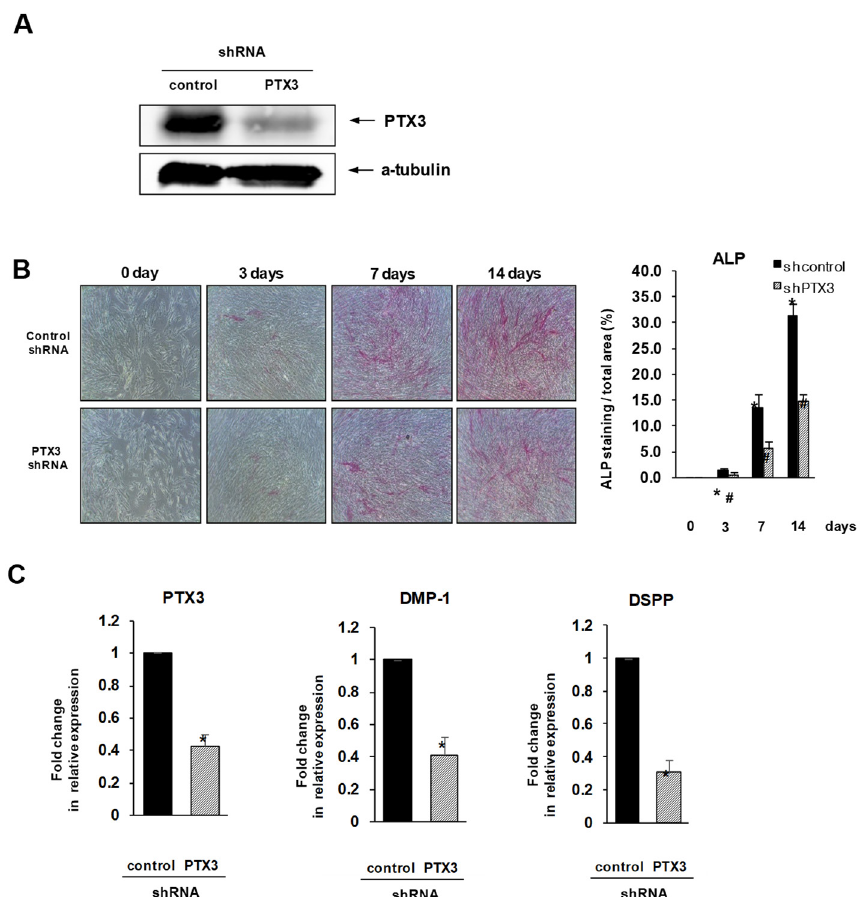
Figure 2. E ff ect of PTX3 knockdown on the expression of osteo / odontogenic di ff erentiation markers in human dental pulp stem cells. ( A ) HDPSCs were stably transduced with lentiviruses encoding PTX3 shRNA or control shRNA. PTX3 expression was analyzed using Western blot analysis. ( B ) HDPSCs transduced with PTX3 shRNA or the negative control shRNA were seeded in osteogenic media for the indicated number of days. ALP staining was conducted at days 3, 7, and 14. Stained cells were observed by a phase contrast microscope at 100 × magnification. ALP-positive areas of HDPSCs were measured by densitometry in triplicate. # p < 0.02 compared to control shRNA-transduced HDPSCs. ( C ) HDPSCs, transduced with either PTX3 shRNA or the negative control shRNA, were cultured in osteogenic media for 14 days. The expression levels of DMP-1 , DSPP , and PTX3 mRNA were evaluated using real-time PCR. The expression level of the control (control shRNA-transduced HDPSCs) was set as 1.0, and the values were normalized to β -actin mRNA levels. * p < 0.01 compared to control shRNA-transduced